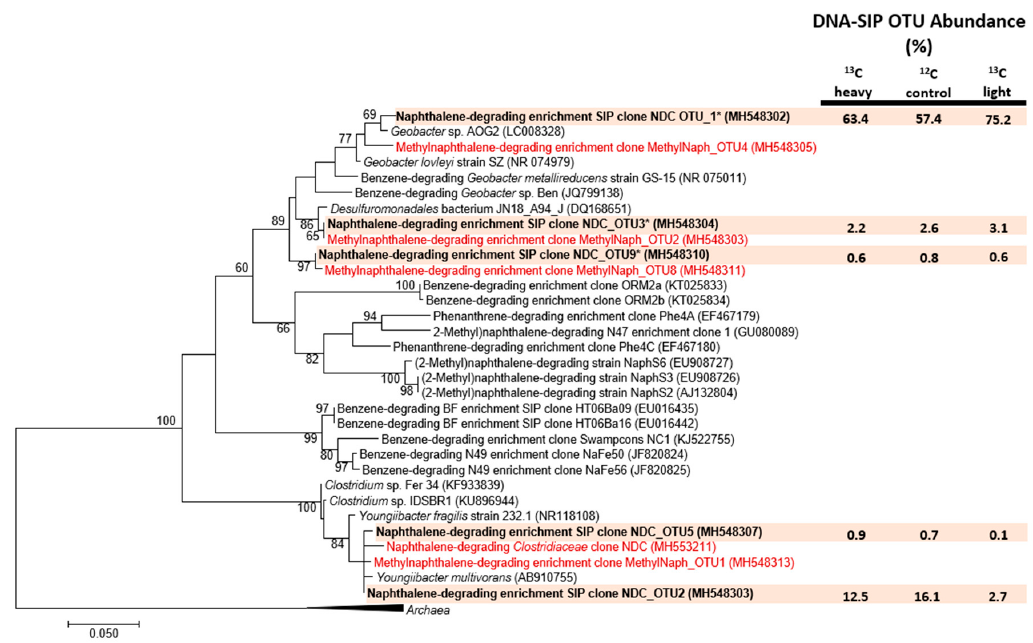
Figure 5. Maximum likelihood consensus tree showing the affiliation of putative 13 C-labeled sequencing OTUs comprising at least 0.5% abundance (bold, shaded) to methanogenic (methyl)naphthalene pyrosequencing clones (red), known anaerobic benzene/PAH degraders and other published reference strains. Evolutionary analyses of aligned nucleotide sequences were conducted in MEGA7; the consensus tree was constructed using the Tamura–Nei model at all nucleotide positions (528 in total) and performing 500 bootstrap replicates (values below 60% are not shown). Archaeal 16S rRNA gene sequences retrieved from NCBI were used to root the tree (collapsed). Asterisks indicate sequences where more than one clone was obtained and a single representative sequence (accession number) was selected for tree construction.